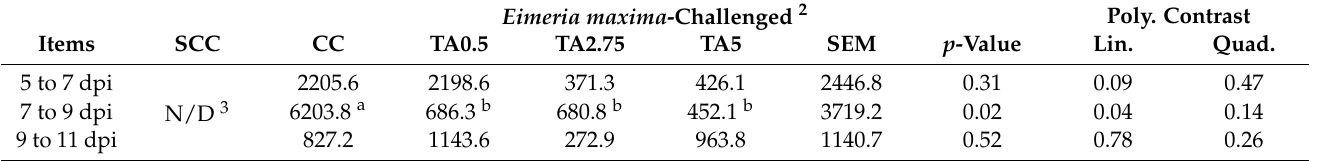
Table 5. Effects of tannic acid supplementation on oocyst shedding (number of oocysts per gram in feces) in broilers infected with Eimeria maxima at 5 to 7 days post-infection (dpi), 7 to 9 dpi, and 9 to 11 dpi 1 . Eimeria maxima -Challenged 2 Poly.